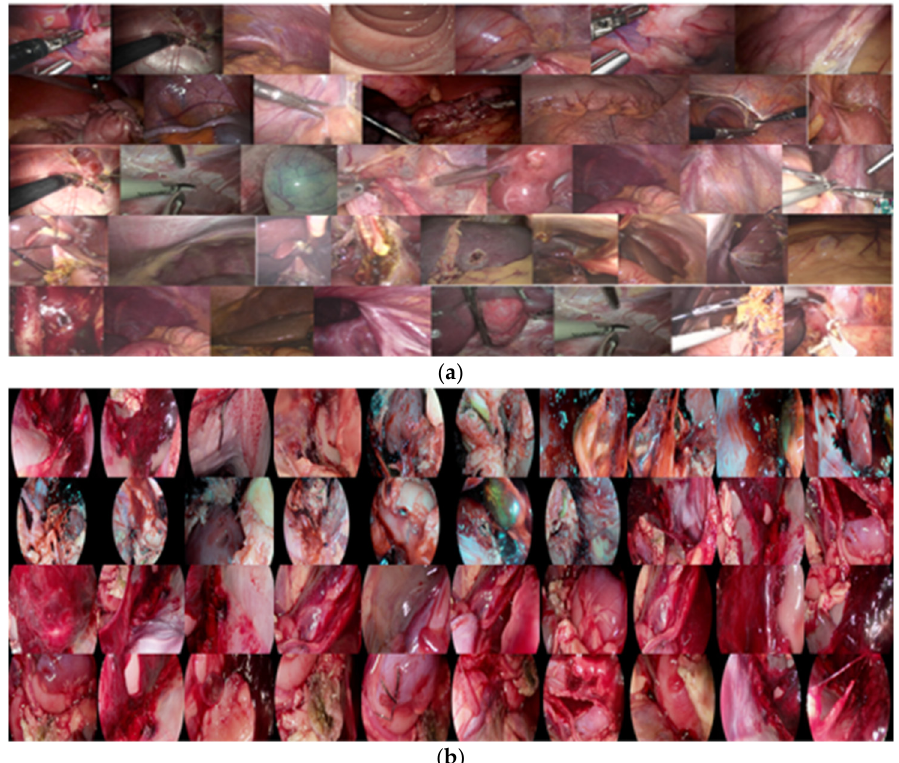
Figure 1. Dataset overview diagram ( a ) Correlation diagram of human tissue ( b ) Correlation diagram of animal tissue.